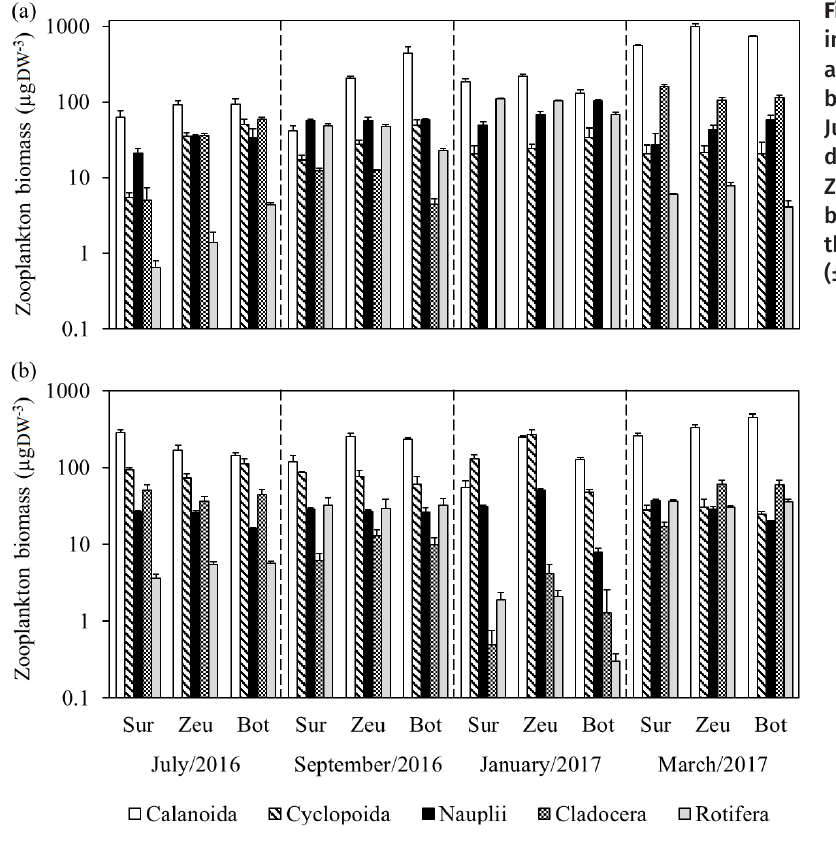
Figure 6. Zooplankton biomass in the mesotrophic (Tabocas, a) and supereutrophic (Tapacurá, b) reservoirs between July/2016 and March/2017 at different depths. Sur = surface; Z = euphotic zone limit; Bot = eu bottom. Vertical lines represent the standard error of the mean